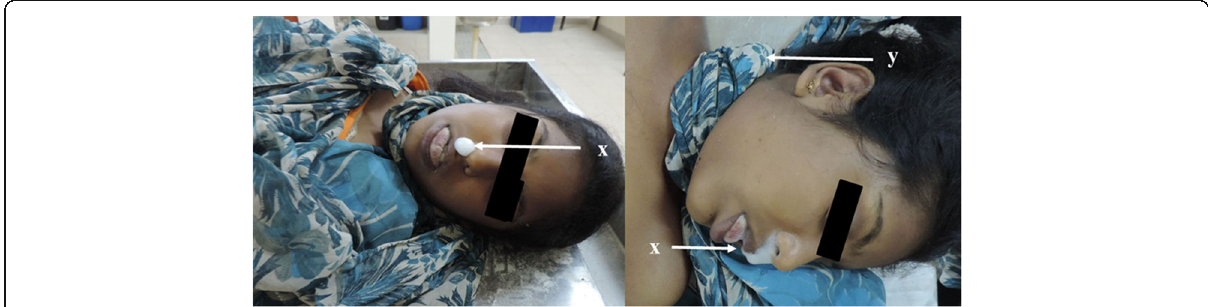
Fig. 1 Plume of froth (indicated by arrow x ) coming from the nostrils and the mouth, the nylon cloth (indicated by arrow y ) used in